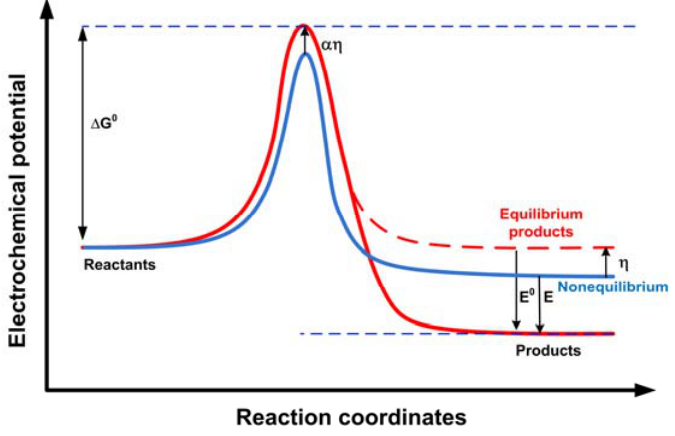
Figure 1. Outer-sphere reaction effect on the reaction